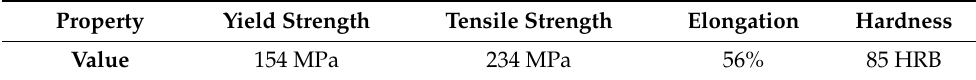
Table 2. Mechanical properties of EN-30B alloy steel (Weight %).